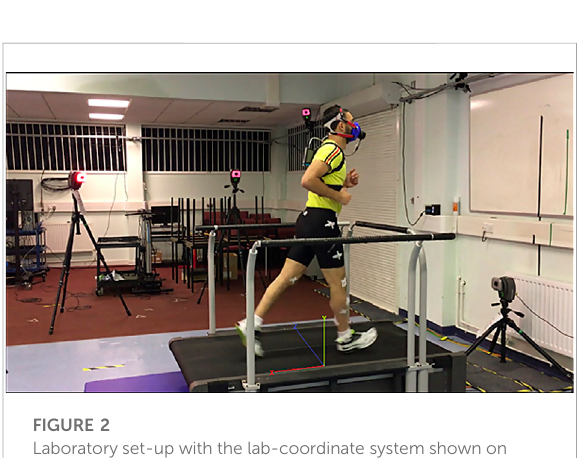
(neutralposition) and used to de fi ne plantar fl exion/dorsi fl exion by